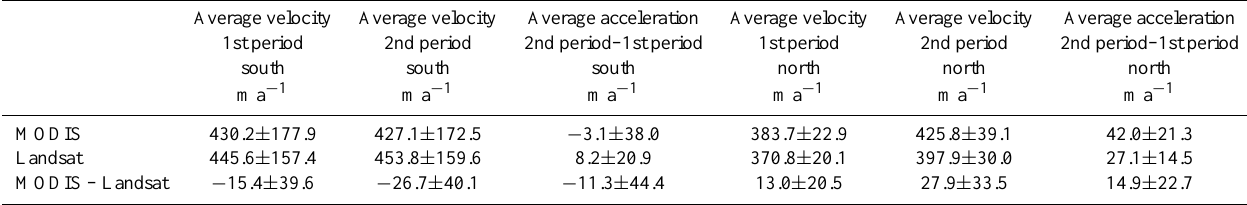
Table 3. Average velocity and velocity difference measured from MODIS and Landsat images for 6 points in the Larsen C North section and 28 points in the Larsen C South section. The RMS of the average is also given.